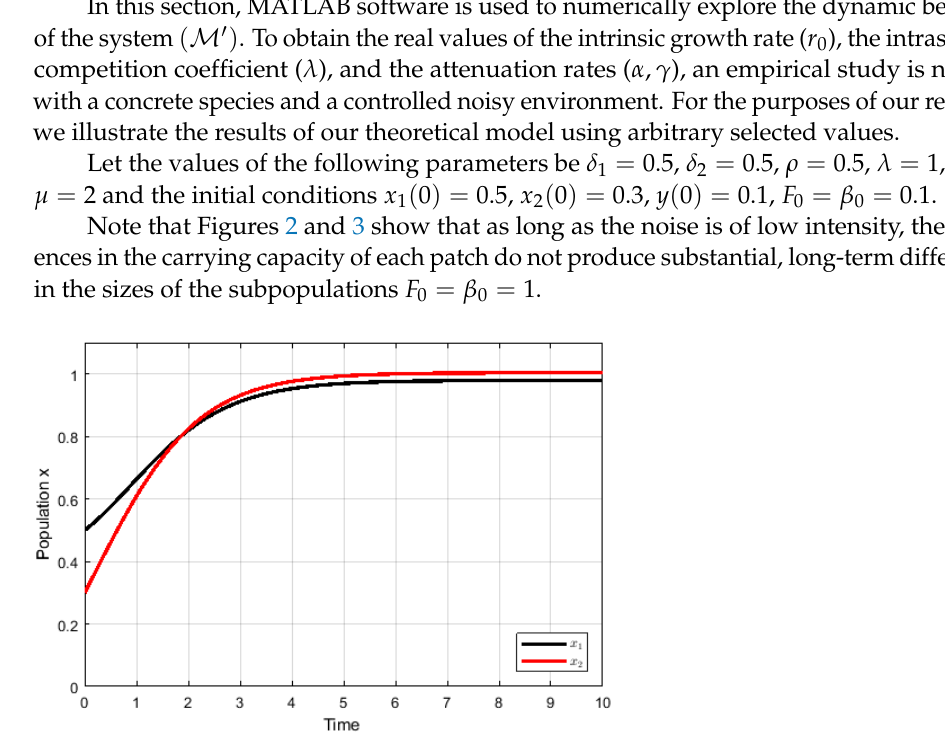
Figure 2. Evolution over time of the occupancy levels of two patches with different noise levels (more noise: black line; less noise: red line), when noise intensity is low. In this simulation, K = 0.5, i.e., the carrying capacity of the noisy patch ( K 1 ) is lower than that of the less noisy patch ( K 2 ).